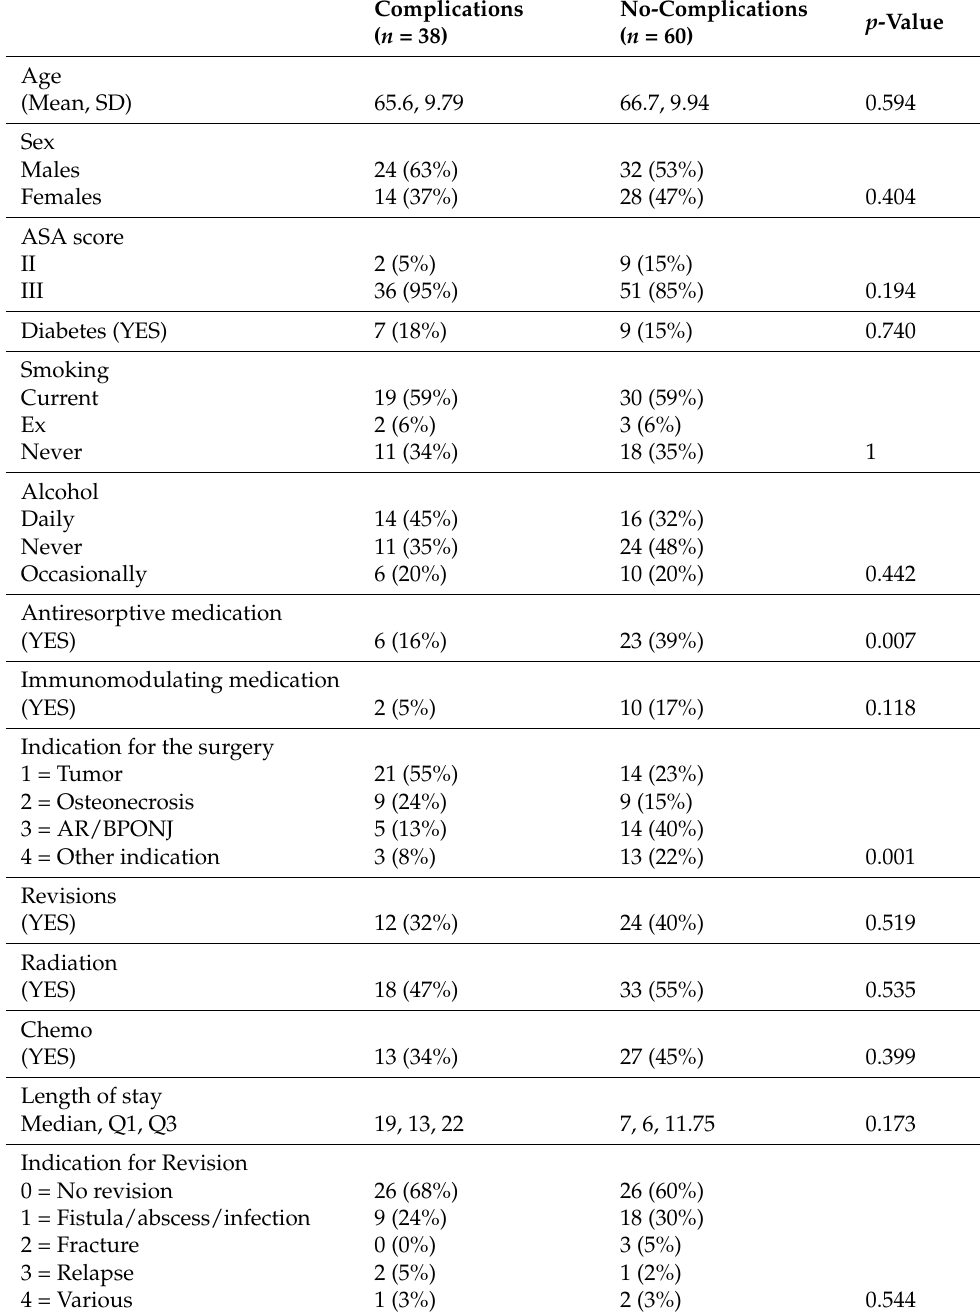
Table 2. Baseline demographic features comparison for complications/no-complications